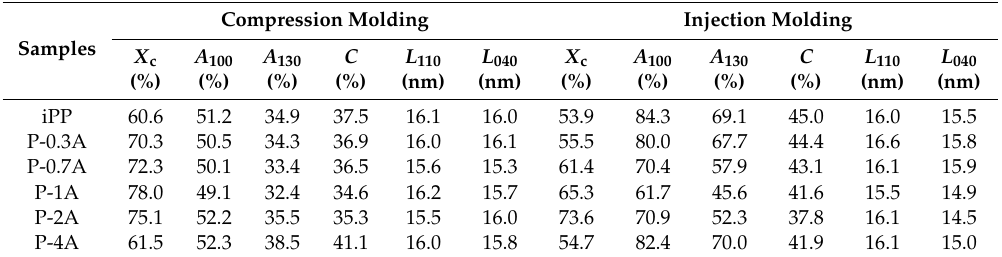
Table 2. WAXD parameters obtained by two di ff erent molding